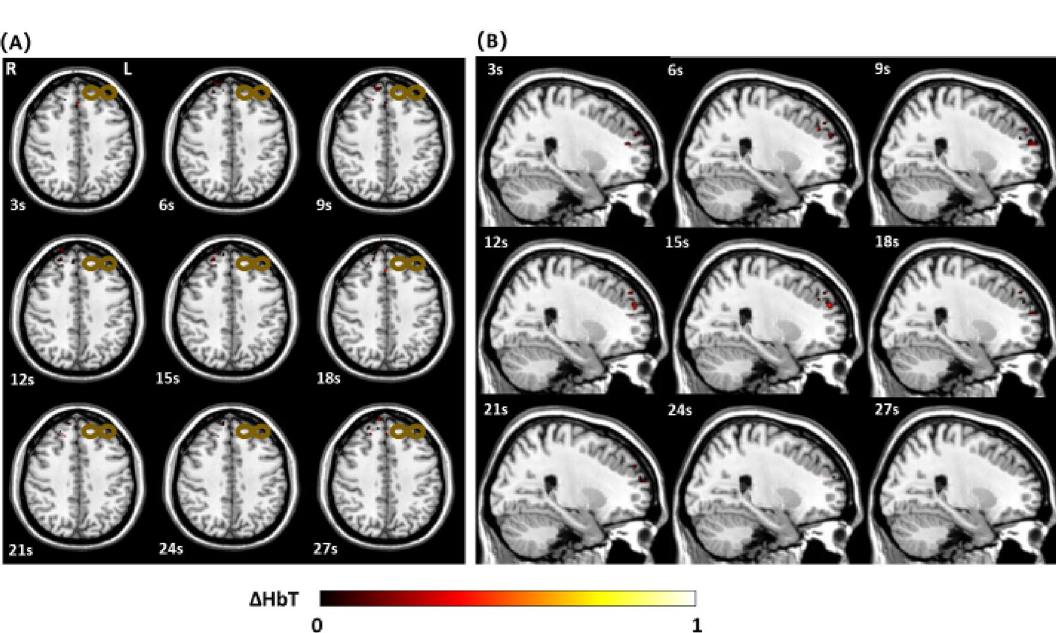
Figure 5. ( A ) Transverse view of the three-dimensional [HbT] images collected by DOT in a depressed subject during a 30 s epoch. ( B ) Sagittal view of the three-dimensional [HbT] images collected by DOT in a depressed subject during a 30 s epoch. Data was only acquired from the right hemisphere of the brain. The bronze colored coil symbol represents stimulation of the left